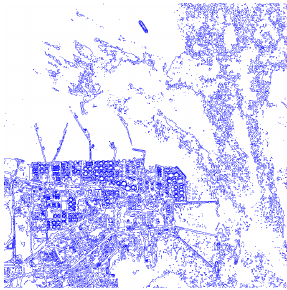
Figure 7. Example of level-line